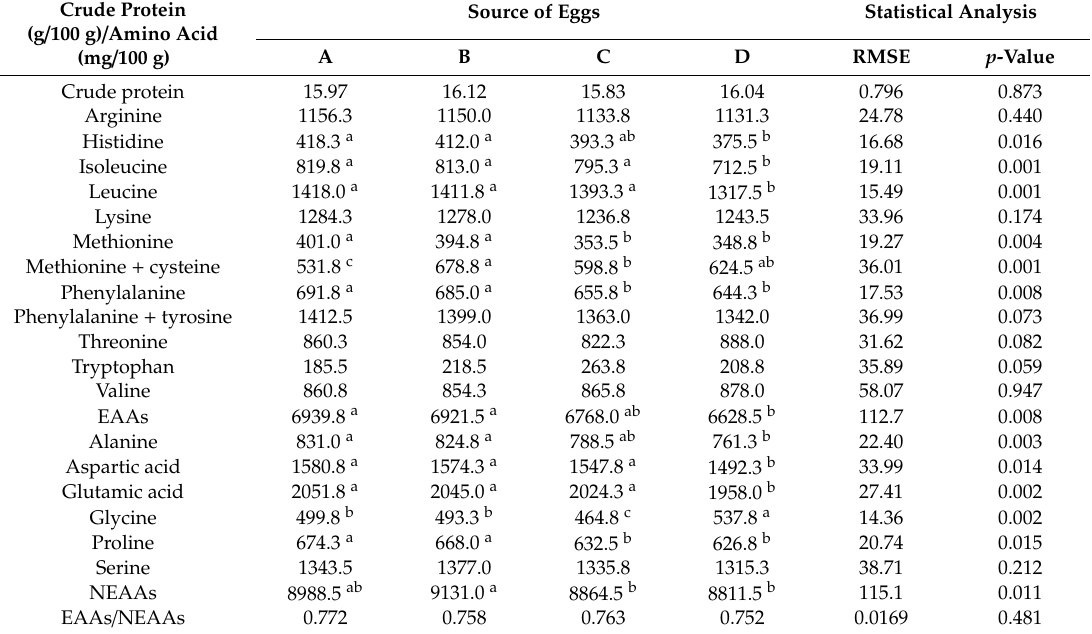
Table 3. Crude protein and amino acid patterns of the yolk of eggs of di ff erent sources in the retail